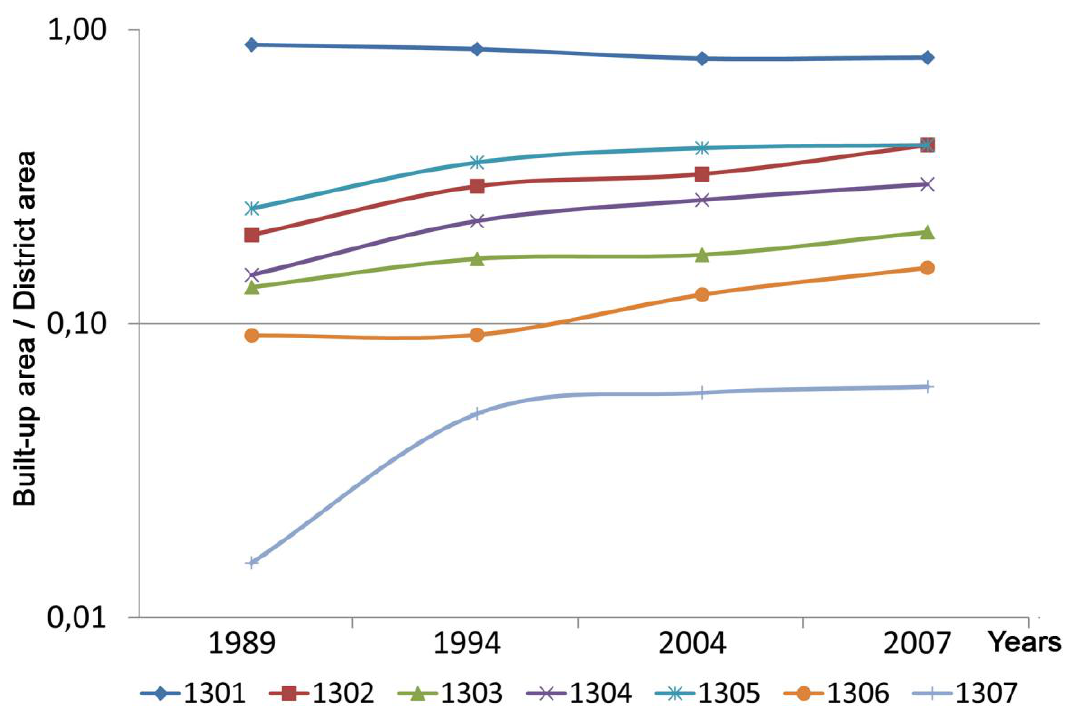
Figure 12. Comparison of built-up densities and density change during the observed period per district. Each curve represents a district. The ordinate shows the observed period from 1989 to 2007. The abscissa indicates the built-up area per district area. A logarithmic scale was chosen to allow for a proportional